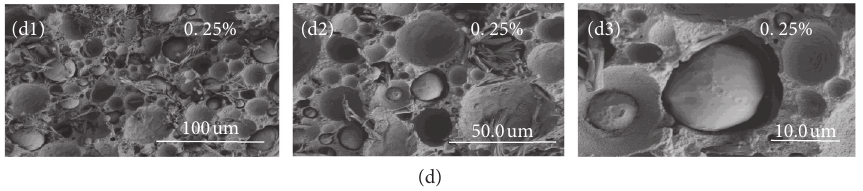
Figure 9: SEM images of the C14 samples: (a) C14-1%, (b) C14-0.75%, (c) C14-0.5%, and (d) C14-0.25%.